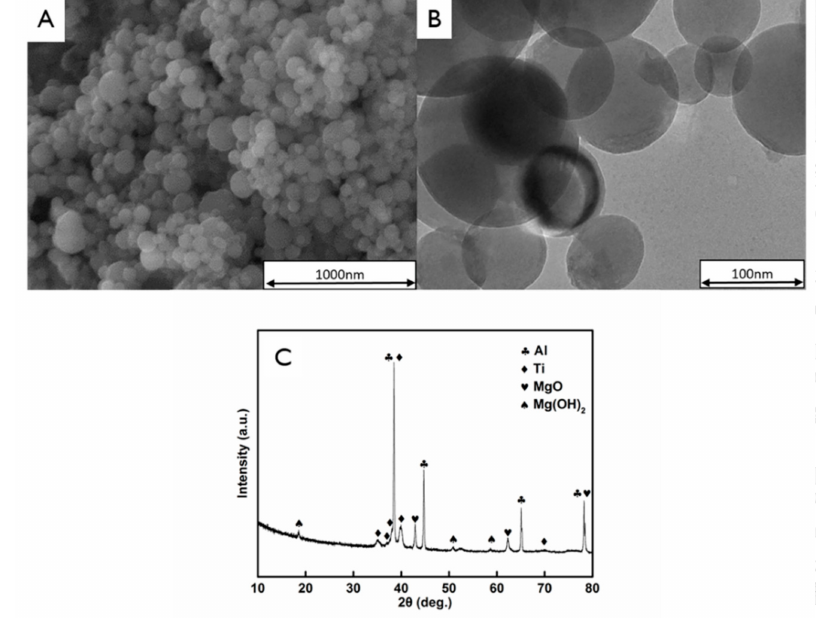
Figure 3. Analysis of the bare AlTi-MgO NPs, showing the: ( A ) Scanning electron microscopy (SEM) image; ( B ) Transmission electron microscopy (TEM) image; and ( C ) X-ray diffraction spectra (XRD)